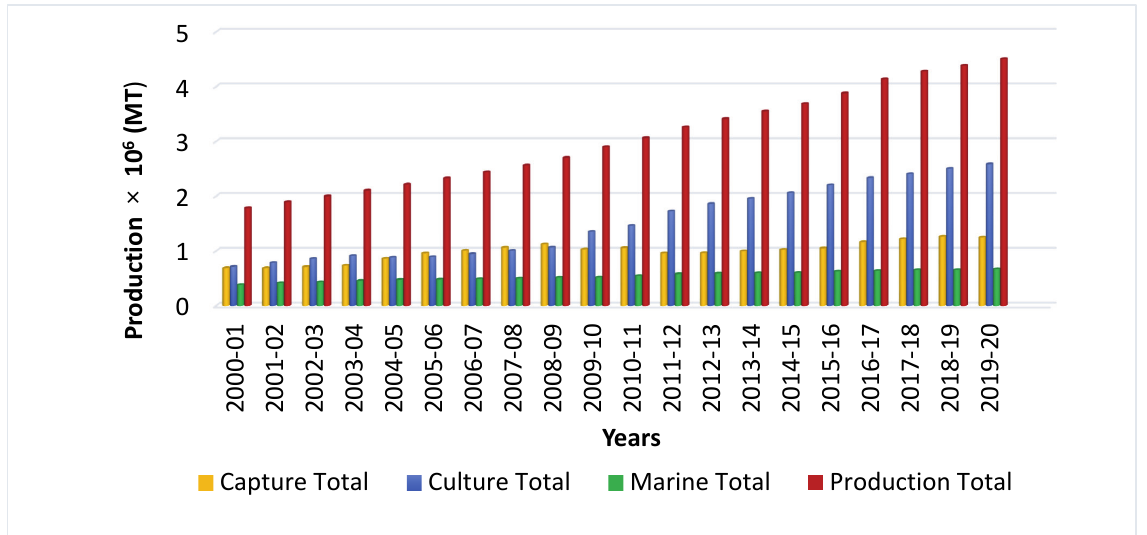
Figure 1. Sector wise annual fisheries production from 2000 to 2020 in Bangladesh [1] . Table 1. Constraints of the Bangladesh fisheries sector as identified by FAO [2].